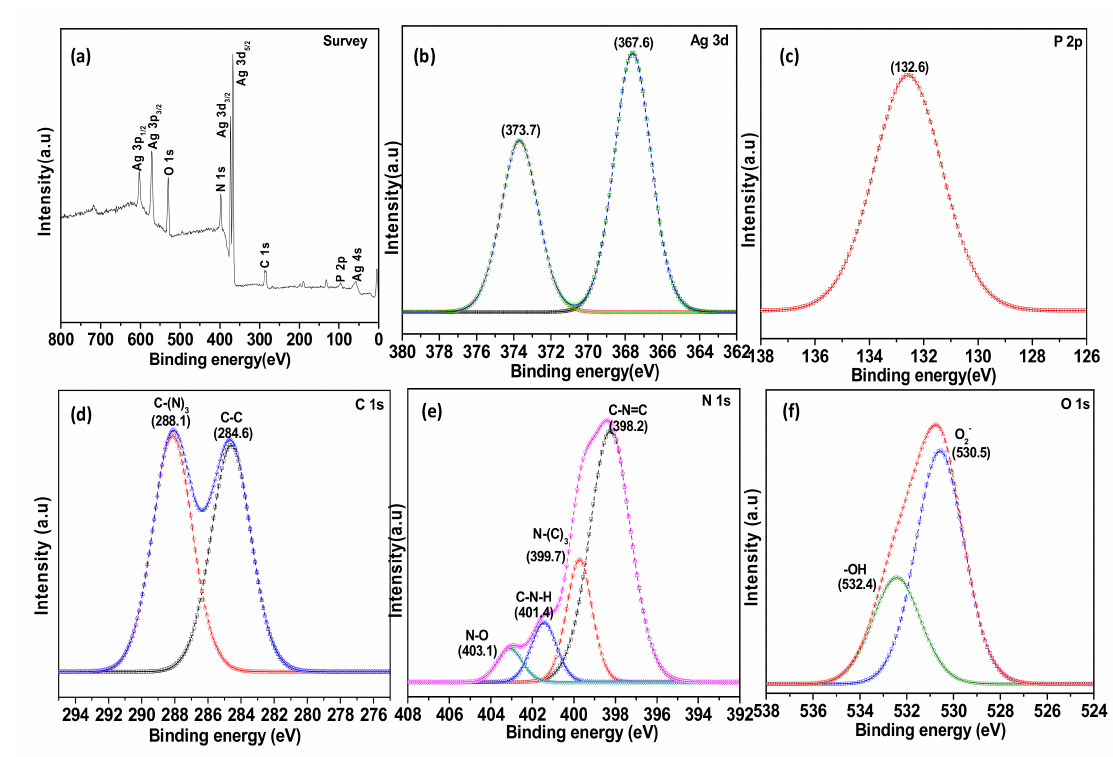
Figure 6. ( a ) Full XPS spectra and high resolution ( b ) Ag 3d peak, ( c ) P 2p peak, ( d ) C 1s peak, ( e ) N 1s peak, and ( f ) O 1s peak of Ag 3 PO 4 /g-C 3 N 4 composite.